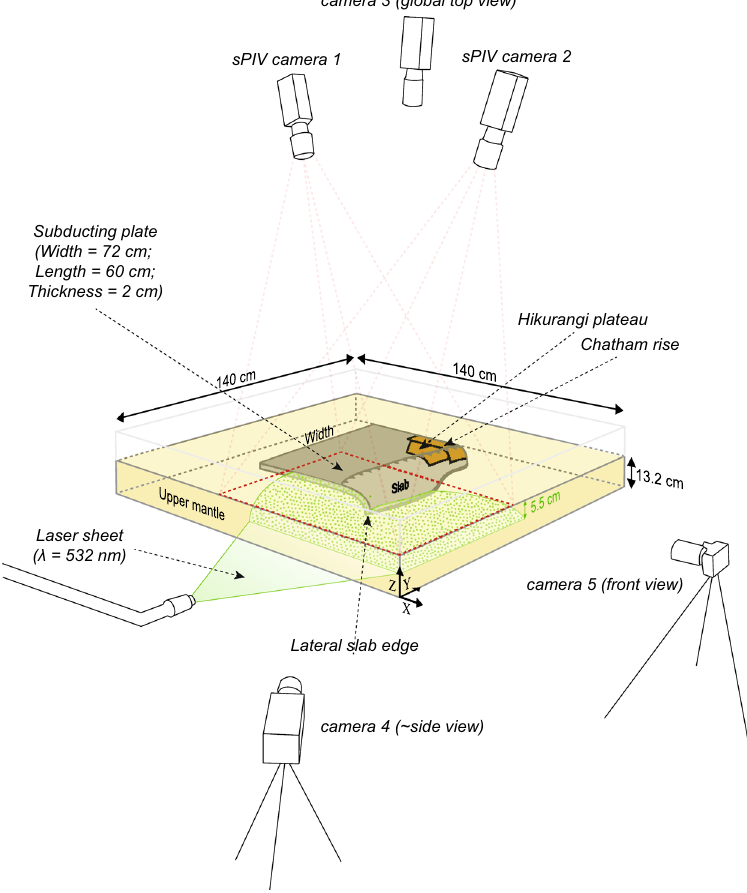
Figure 2. Experimental setup with the subducting plate depicted during the slab free sinking phase of the subduction process. The scaling with the natural prototype is done by ensuring that dynamic similarity is respected (see Methods for details). sPIV cameras 1 and 2 were placed in stereoscopic arrangement above the model and recorded pictures during intermittent laser sheet emission, which illuminated phosphorescent particles at 5.5 cm (275 km) depth inside the glucose syrup that simulates the sublithospheric upper mantle. Cameras 3, 4 and 5 were fixed and dedicated to study the subducting plate kinematics. The 3 components of the mantle flow velocity field on a plane could be calculated using a stereo cross-correlation technique. This figure is modified from Strak and Schellart 23